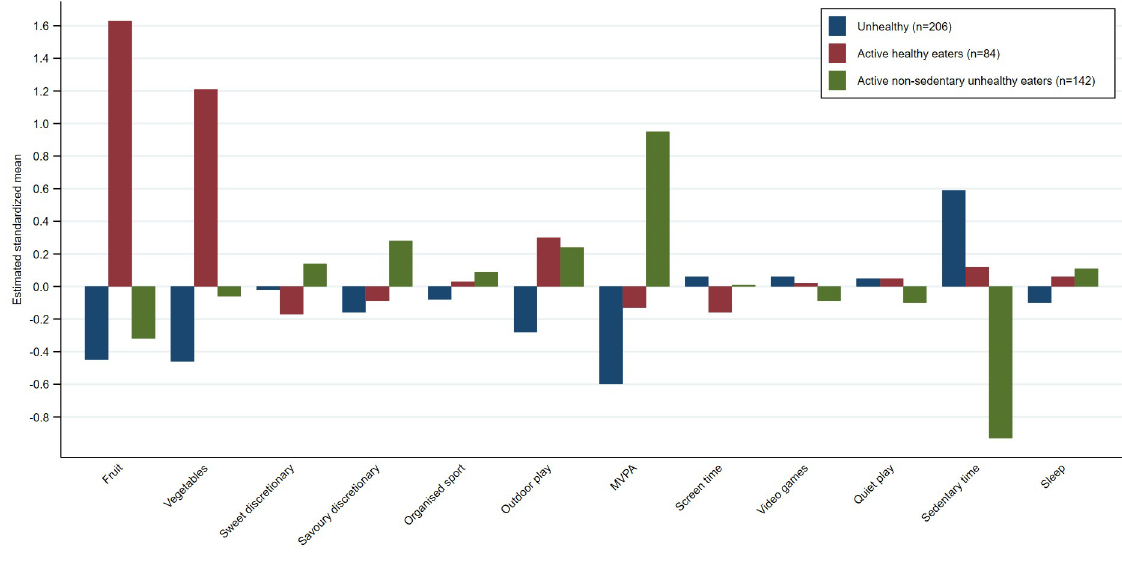
Fig 2. Average value of the standardized input variables for the behavioural patterns derived using latent profile analysis. Footnote: n; number of children in each